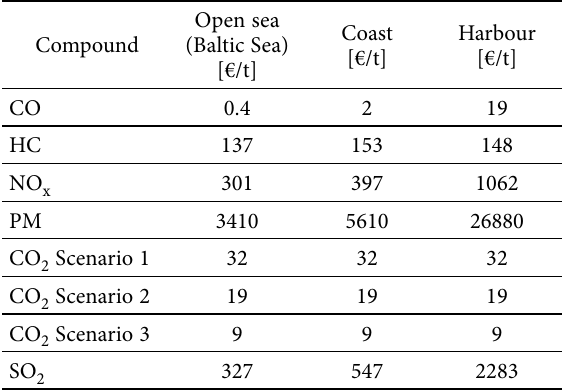
Table 2. Emission externalities for the open sea, near coast and harbour spatial divisions – unit costs are given per compound and spatial category (€/t) (MINTC 2003)